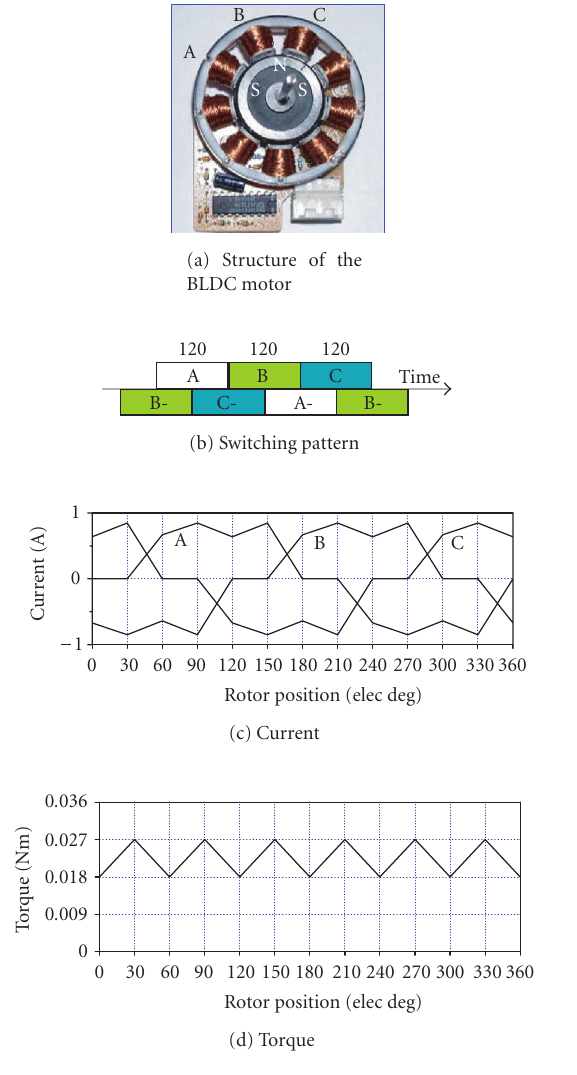
Figure 4: Switching pattern, current and torque curves of the BLDC motor.